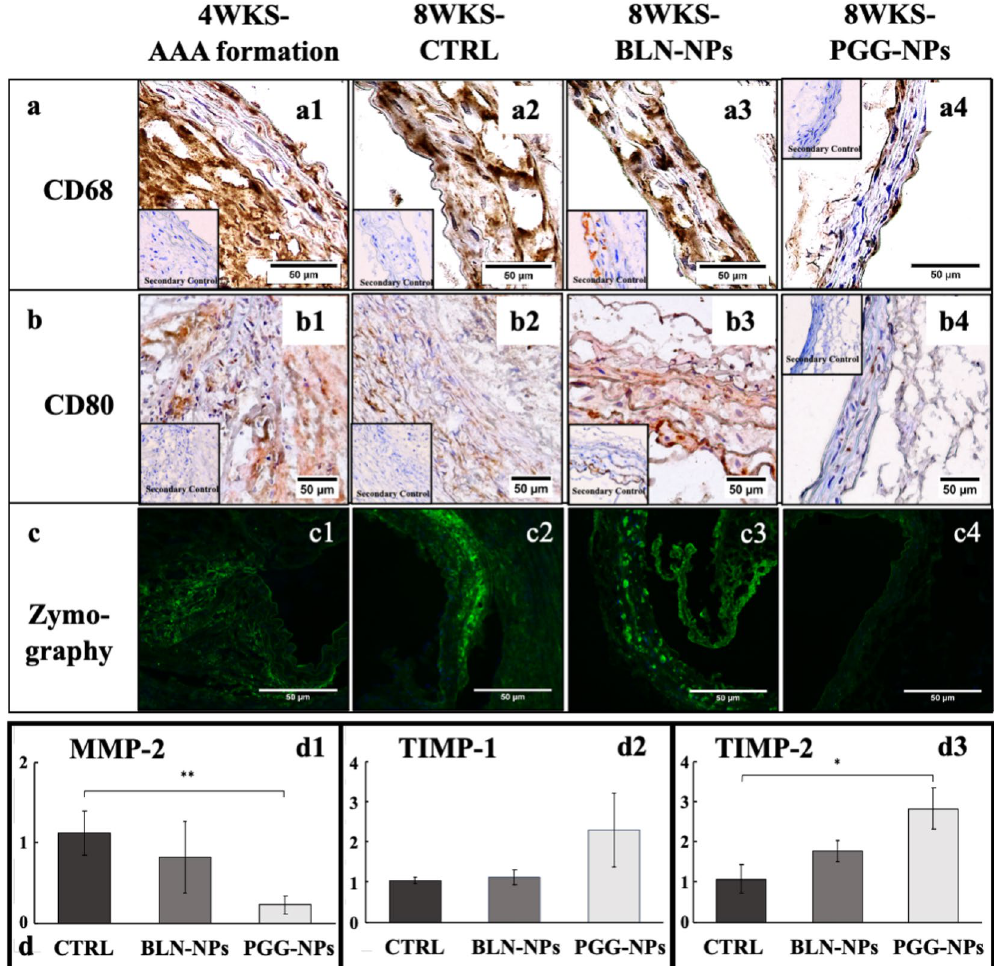
Figure 6. Local inflammatory response analysis of aneurysmal tissues. ( a , b ) IHC results for CD68 (a1-a4), staining for pan macrophage infiltration, and CD80 (b1-b4), staining for M1 macrophages, in the suprarenal aneurysmal aortic tissue from 4-week group (before therapy), and at 8-wks for control, BLN-NPs, and PGG-NPs groups. PGG therapy reduced macrophage infiltration in the AAA sites; ( c ) In-situ zymography showing MMP gelatinolytic activity in aneurysmal tissue from 4-week group (before therapy), and at 8-wks control, BLN-NPs and PGG-NPs groups; ( d ) qPCR results of mRNA extracted from aneurysms harvested for MMP-2, TIMP-1 and TIMP-2 expression showing reduction of MMP-2 (*p < 0.05) and increase in TIMP-1 and -2 in PGG